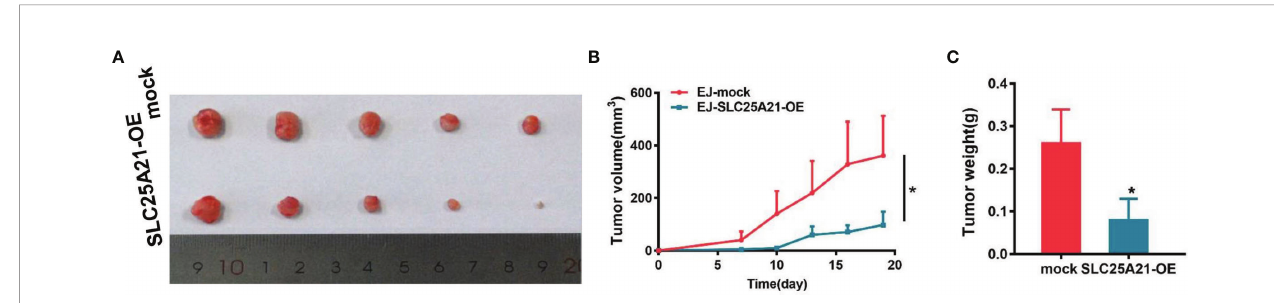
FIGURE 3 | SLC25A21 overexpression suppresses BCa cell proliferation in vivo . (A) SLC25A21 overexpression inhibited subcutaneous tumor formation in nude mice. EJ cells with SLC25A21 upregulation and control cells were inoculated into nude mice (n = 5 per group). (A) The xenografts of 30days after ectopic- subcutaneous implantation of with SLC25A21 overexpressing and control cells into nude mice. (B, C) The effect of SLC25A21 overexpression on BCa tumor growth was evaluated based on tumor volume (B) and tumor weight (C) in the two groups. * P